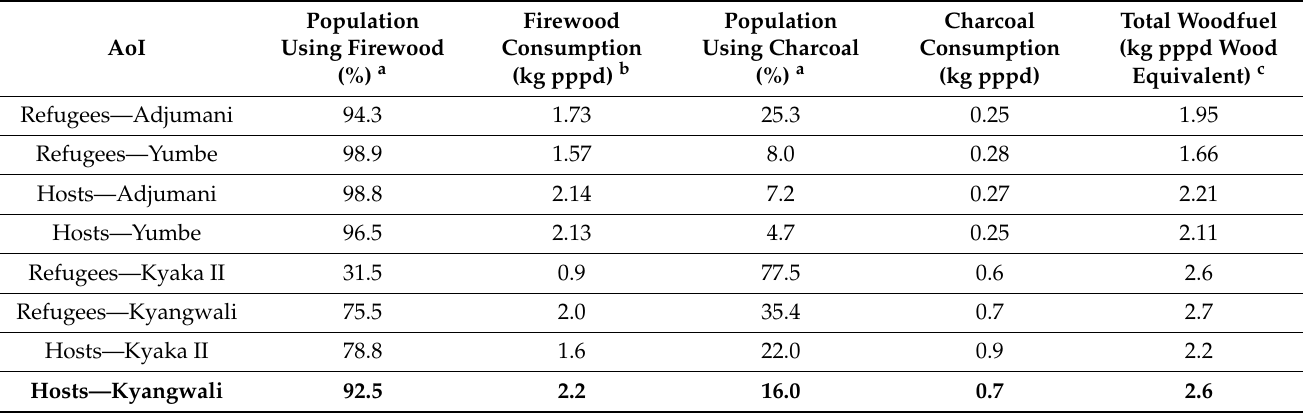
Table 5. Refugee and host woodfuel consumption in the sampled target refugee hosting areas in northern and southwestern Uganda.